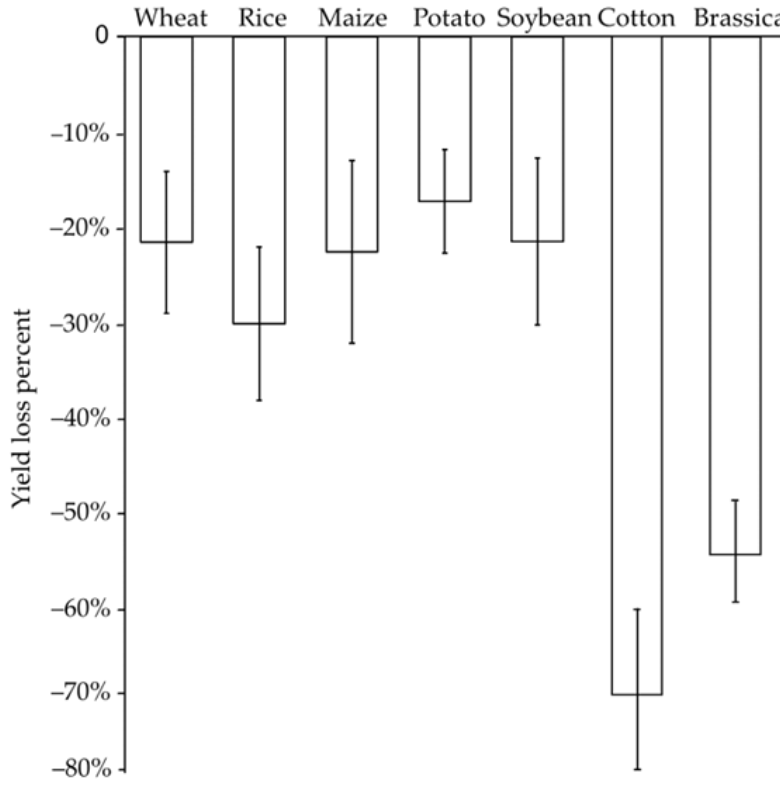
Figure 1. Global yield loss to pathogens and pests on major food crops.